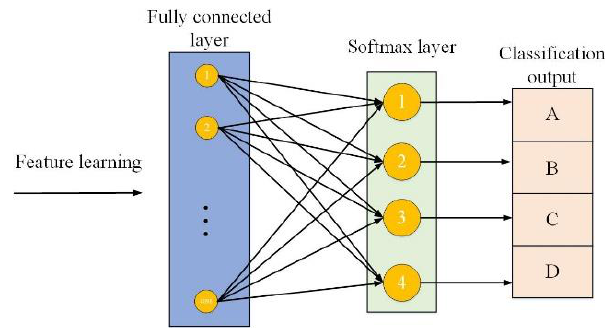
Figure 3. Modified softmax layer and classification.